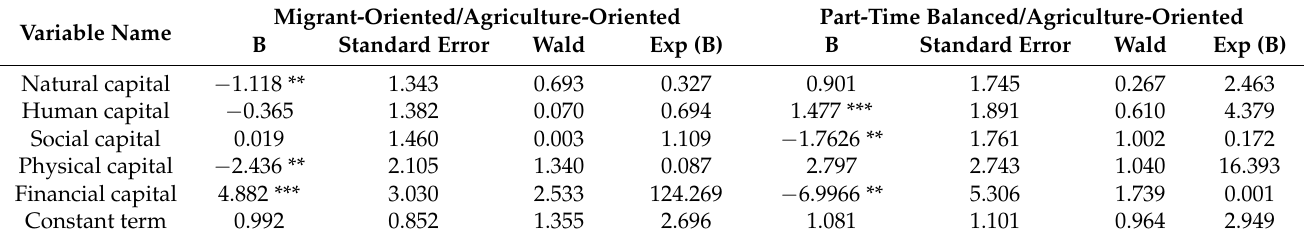
Table 7. Regression results of the impact of livelihood capital on livelihood strategy